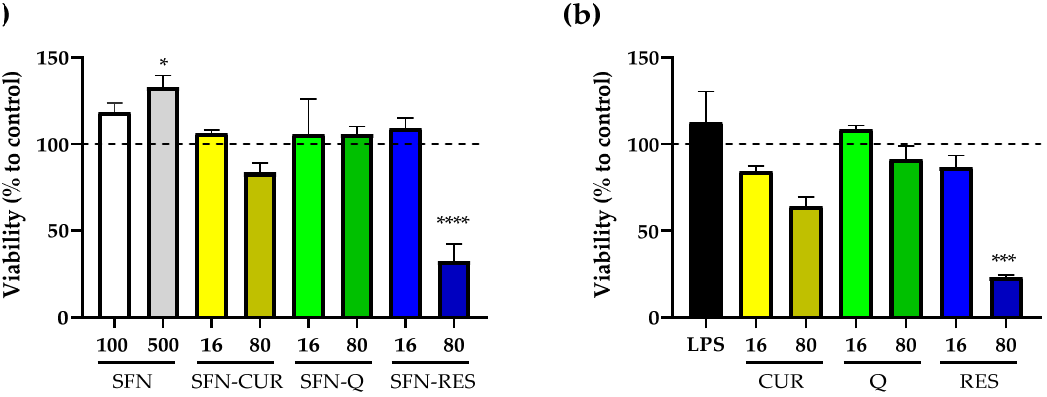
Figure 7. Effect of SFN-PPh and free PPh on the cell viability of human macrophage HL-60 dif- ferentiated cells measured by MTT assays (n = 3, three independent experiments performed in triplicate). ( a ) Cell viability in the presence of 100 or 500 µ g · mL − 1 of nanoparticles, equivalent to 16 or 80 µ g · mL − 1 of CUR, Q and RES according PLC. ( b ) Cell viability of HL-60 cells treated with free PPh (CUR, Q and RES) at the equivalent concentrations (16 and 80 μ g·mL ‒ 1 ). Data are presented as % of cell viability ± SE of LPS-stimulated (0.1 μ g·mL ‒ 1 ) HL-60 differentiated cells. Statistical differences were calculated using the two-way ANOVA test, followed by Dunnet’s post hoc analysis and rep- resented as * p < 0.05; *** p < 0.001; **** p < 0.0001. All data presented are normalized compared to